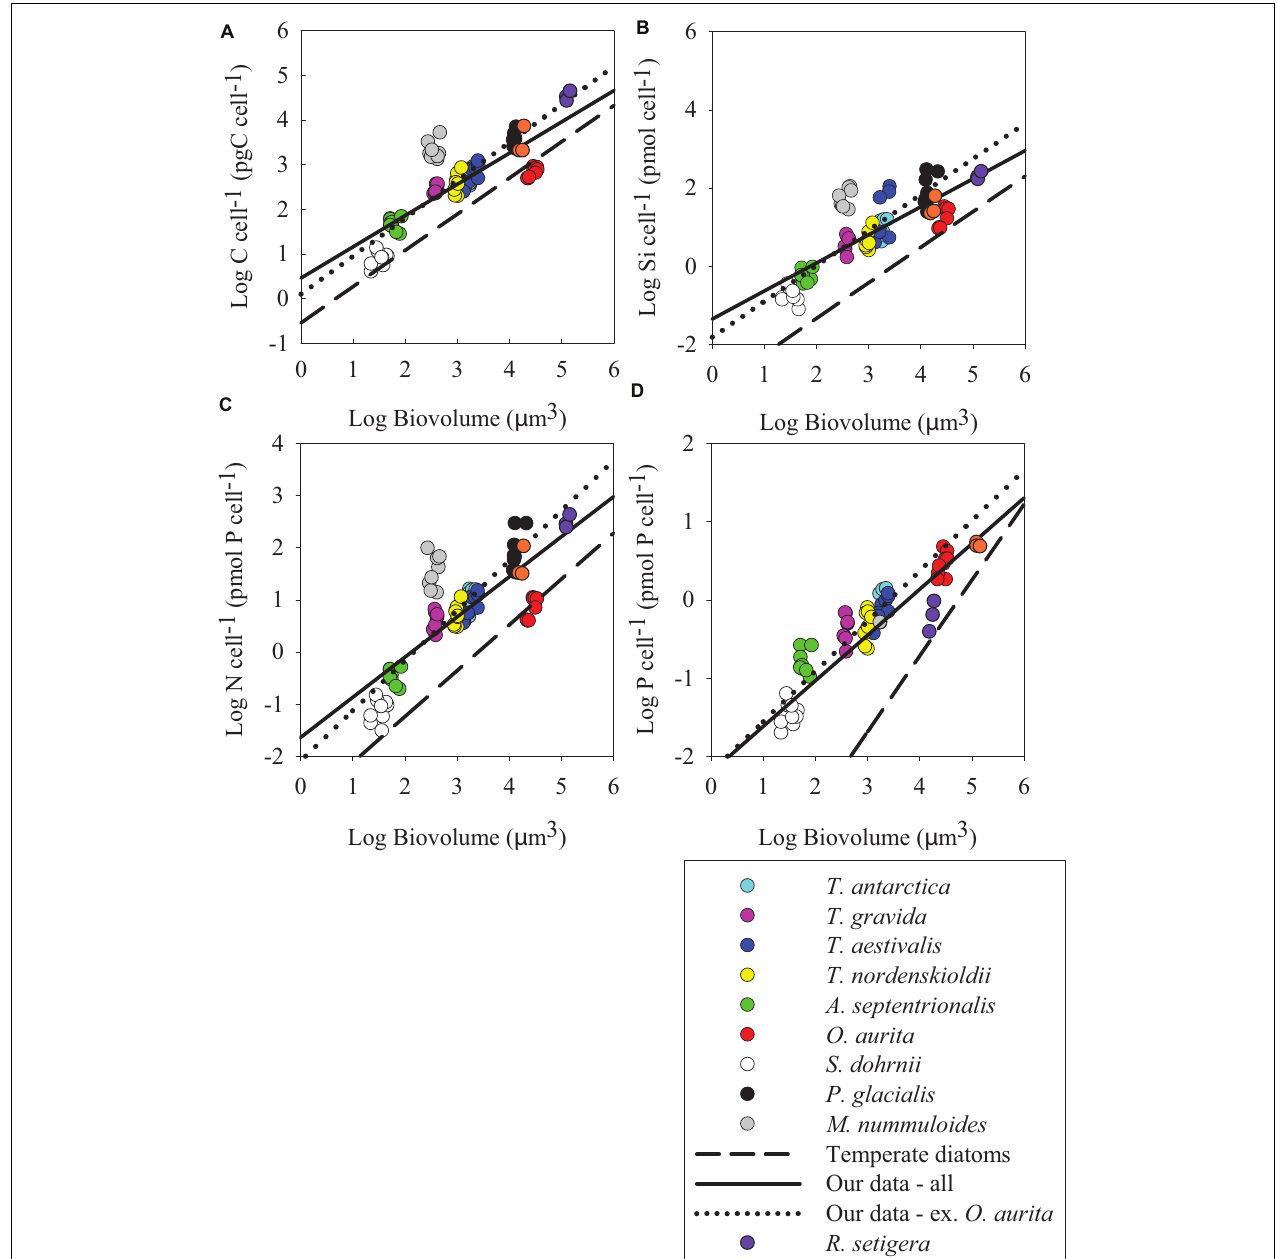
FIGURE 3 | Log–log plots of cell element quotas (pmol cell − 1 ) versus cell biovolume ( µ m 3 ) at the early-stationary sampling point; (A) carbon quota, (B) silicon quota, (C) nitrogen quota, and (D) phosphorus quota. All else as in Figure 2 .